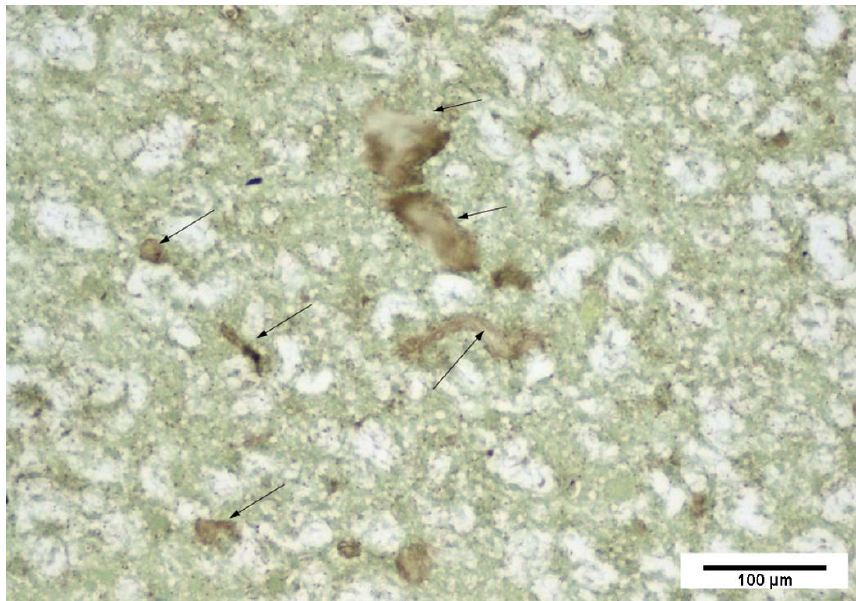
Figure 3. Positive sample of processed cheese, lectin histochemistry, background staining B-Calleja (green—protein, brown—carrageenan (arrows)).